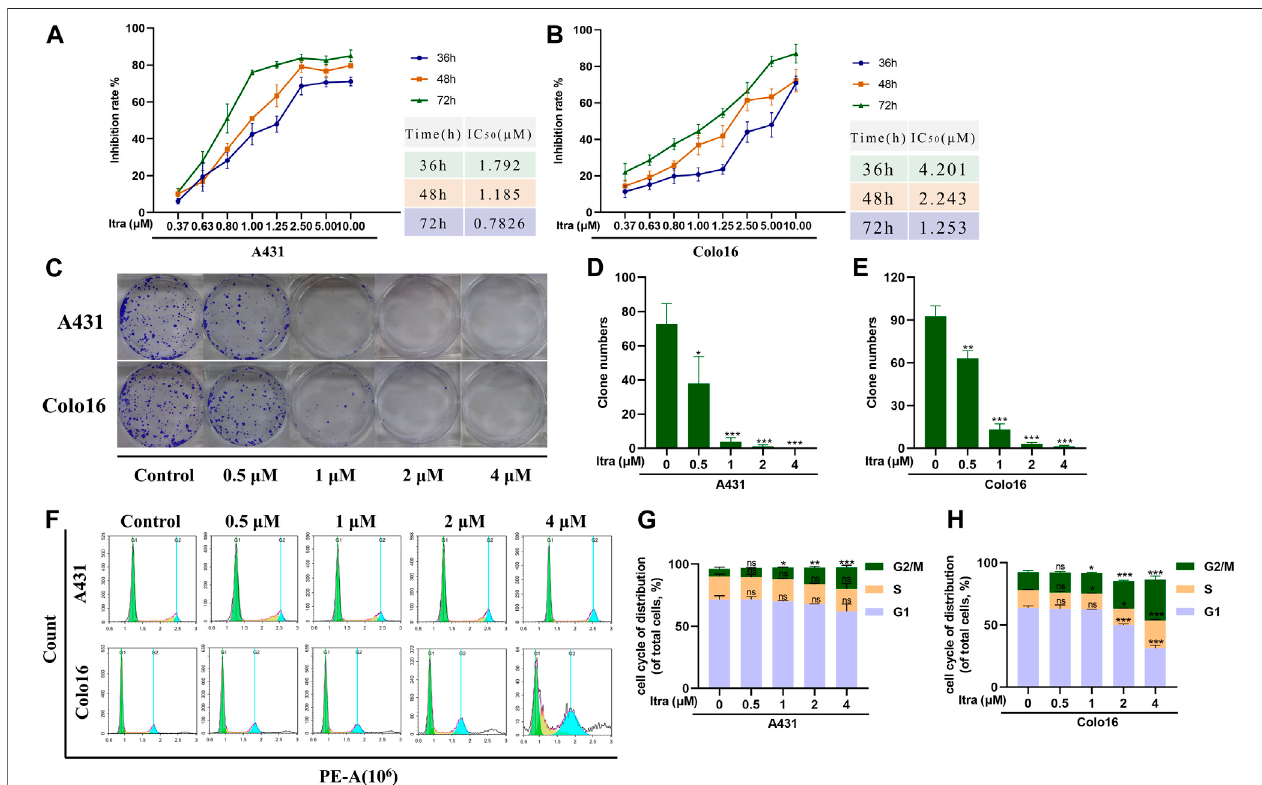
FIGURE 1 | Itraconazole inhibits proliferation and induces G2/M cell cycle arrest of human cSCC cells. (A,B) A431 and Colo16 cells were treated with indicated concentrations of itraconazole for 36, 48 and 72 h. Inhibition of cell viability was analyzed by CCK8 assay. (C – E) Crystal violet-stained colonies under an inverted microscope. (F – H) Cell cycle analysis via fl ow cytometry. [mean ± S.D. (error bars), n = 3; * p ≤ .05; ** p ≤ .01; *** p ≤ .001, compared with control